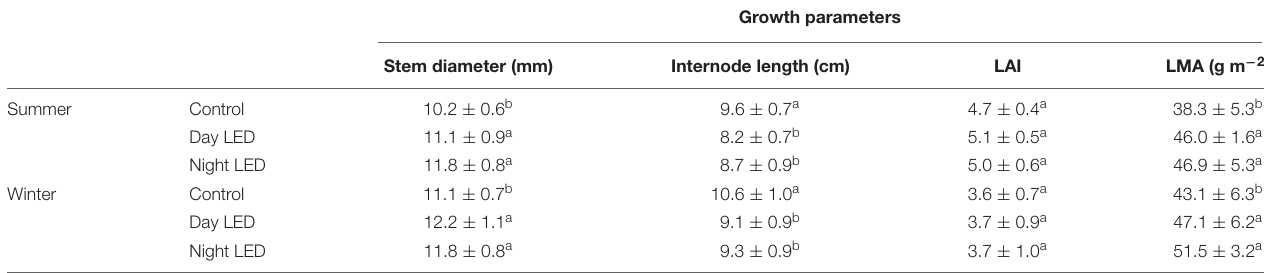
TABLE 2 | The effect of LED inter-lighting on growth of single-truss tomato plants.